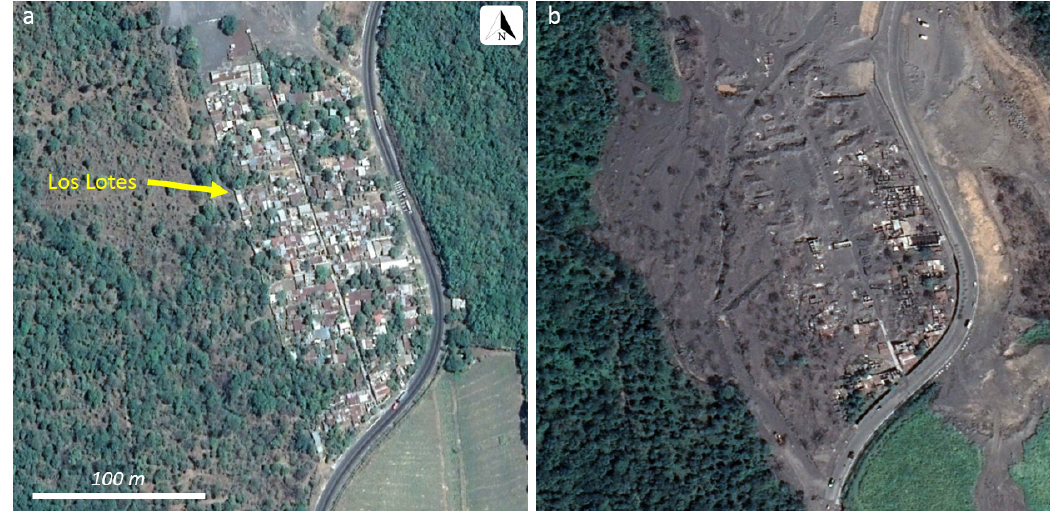
Figure 2. Satellite images of the La Réunion golf resort. Las Lajas barranca (outlined) lies directly to the west of the resort and golf course. ( a ) 7 March 2018 (prior to the eruption). ( b ) 14 November 2018 (~5 months after the eruption). Images from Google Earth.